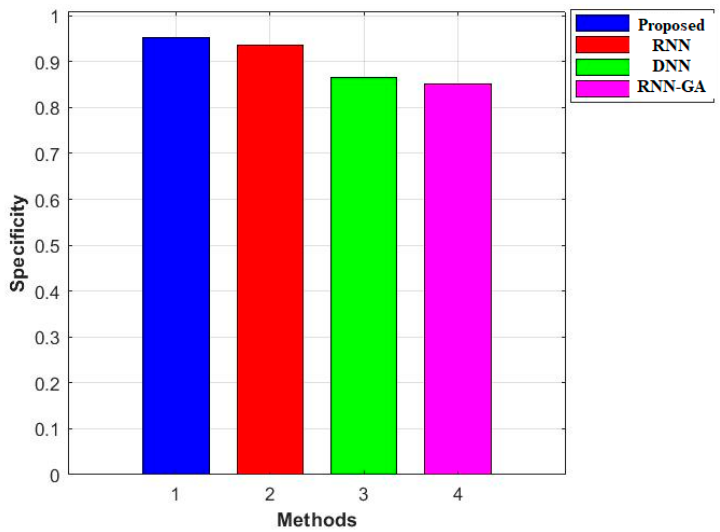
Figure 12. Sensitivity performance of confusion matrix.